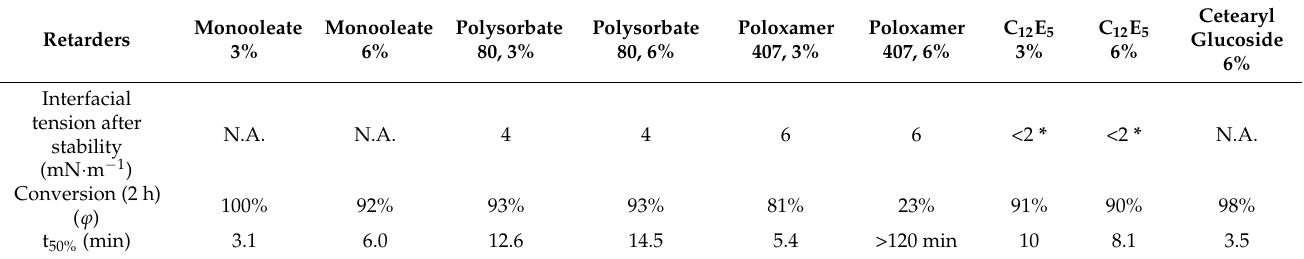
Figure 3. ( a ) Conversion of digestible interfacial retarders: monooleate 3%, and polysorbate, 3% and 6%, respectively. ( b ) Conversion of undigestible interfacial retarders: poloxamer 407 3% and 6%. ( c ) Conversion of undigestible interfacial retarders: cetearylglucoside 6%, C12E5 3% and 6%. Table 5. Interfacial tension after the stability and conversion: monooleate, polysorbate 80, poloxamer 407, and cetearyl